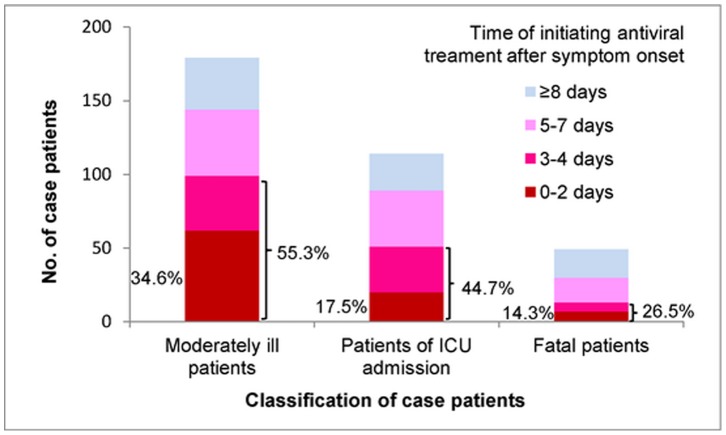
Days from symptom onset to antiviral treatment initiation among Hospitalized cases with influenza A (H1N1)pdm09 infection, China, during the winter season of 2010–2011 (n = 342).Bar labels in the left side of each bar denote percent of hospitalized cases within 2 Days from symptom onset to Antiviral treatment initiation. Bar labels in the right side of each bar denote percent of hospitalized cases within 4 Days from symptom onset to Antiviral treatment initiation.